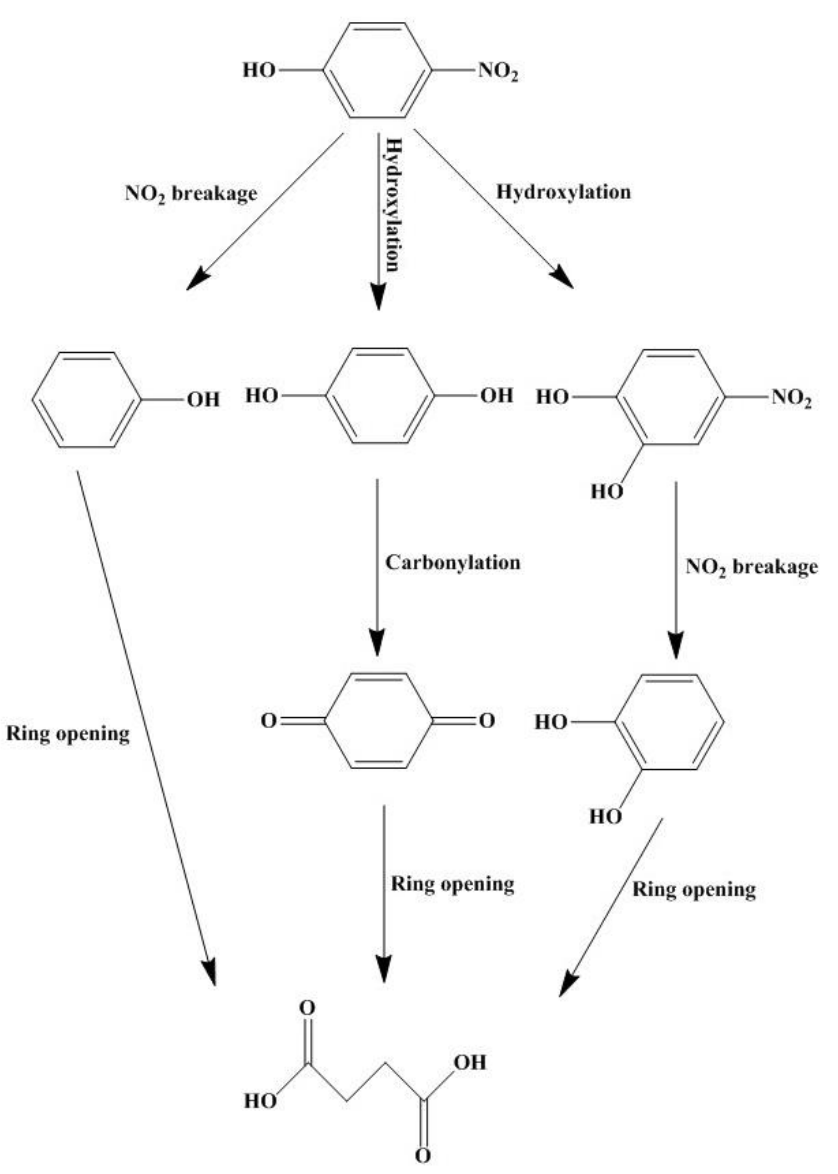
Figure 10. Degradation pathway of MO.